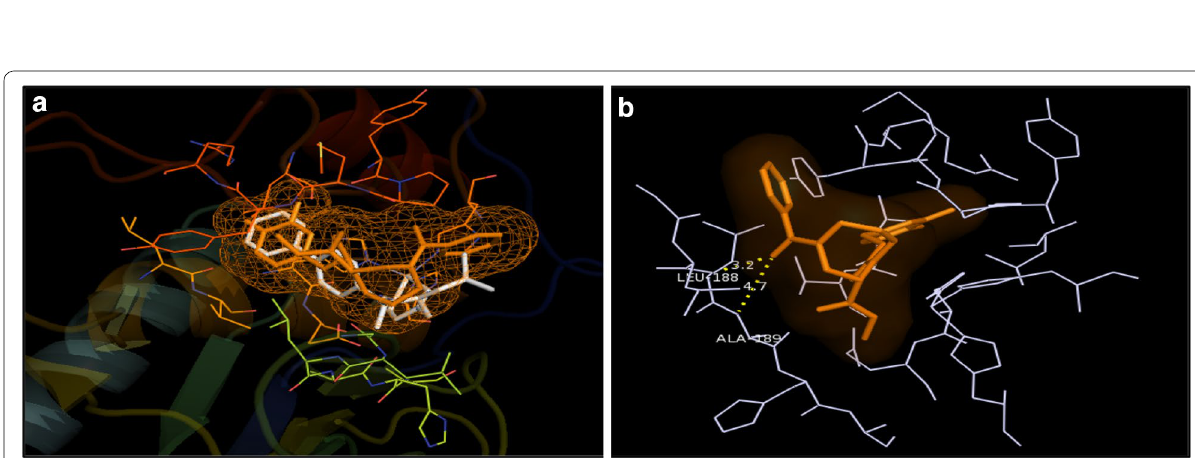
Fig. 10 a Overlay of the docked pose of compound 15 (orange) with that of PDB Ligand 4H3X (white); b docked pose: H-bond interaction of compound 15 in the binding site of MMP-9